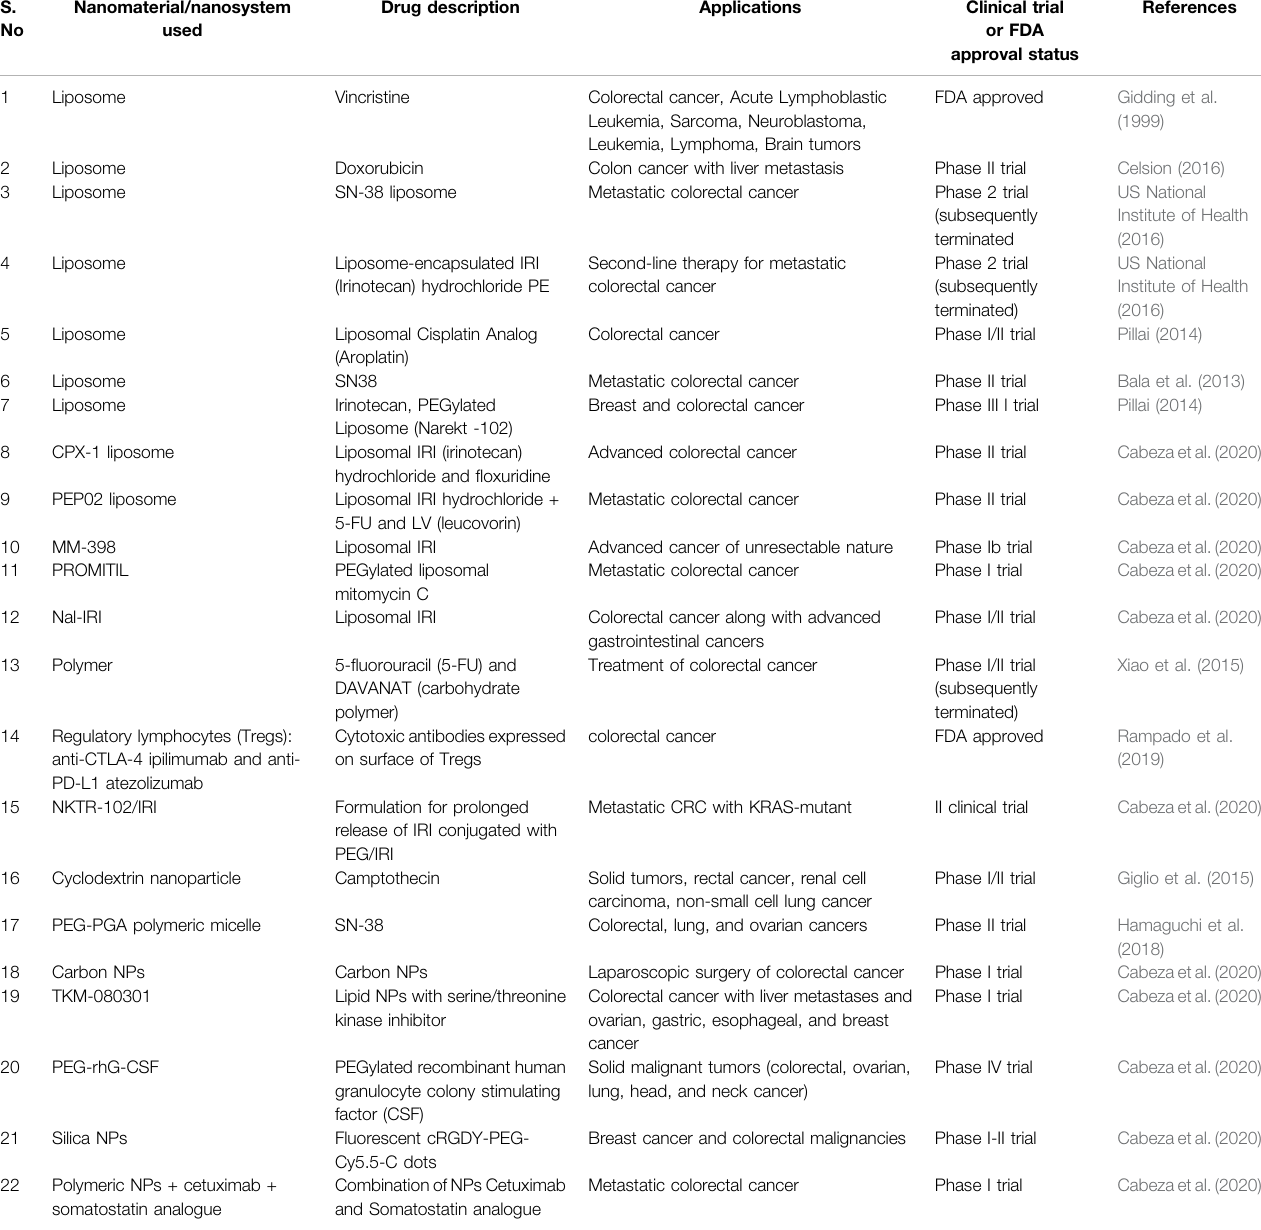
TABLE 4 | Nanoparticle-based FDA drugs and drugs in clinical trials on CRC patients. S.